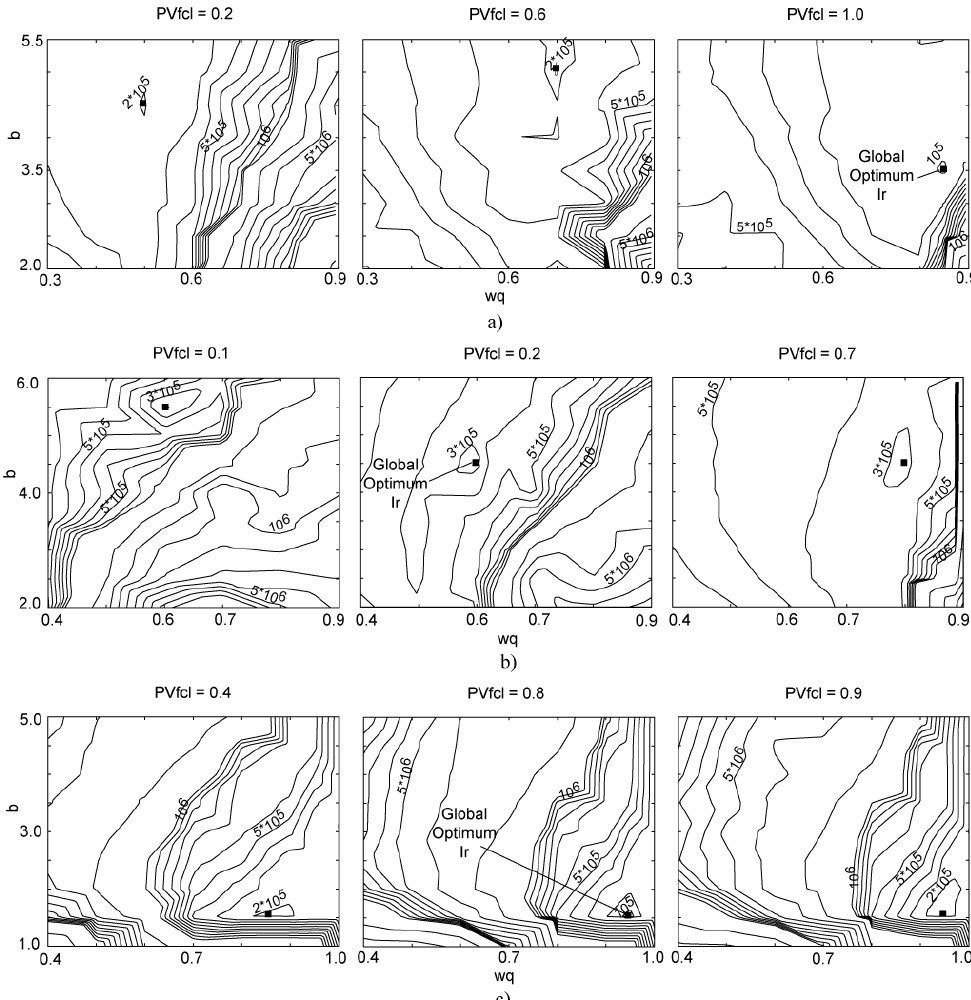
Figure 7. Results of the simulations: values in Ir (€) for the various configurations analysed. The minimum Ir (black box) is shown for each selected value of PVfcl. The general optimum value of Ir is labelled for each case study: (a) Puentes Dam; (b) Talave Dam; and (c) Fuensanta Dam